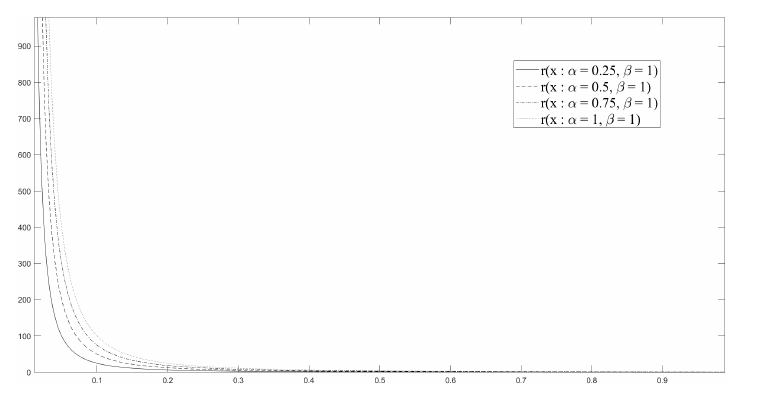
Figure 6 – Reverse hazard rate functions of unit-Gompertz distribution for ( α = 0.25, β = 1 ) , ( α = 0.50, β = 1 ) , ( α = 0.75, β = 1 ) & ( α = 1, β = 1 )